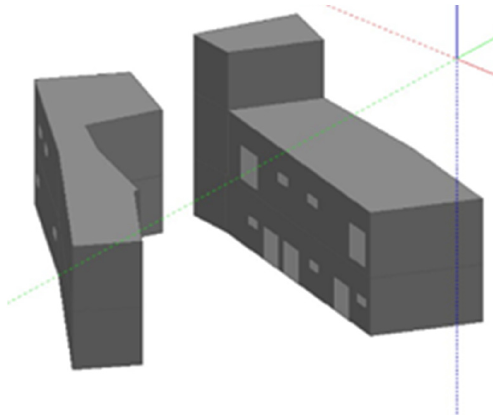
Figure 17. Riyadh traditional house without courtyard corridor (Case 1).